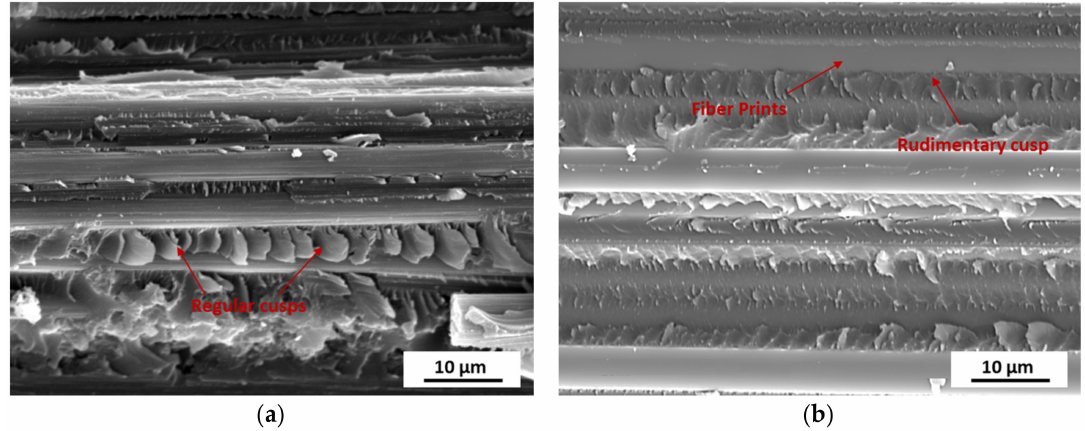
Figure 11. SEM images of fracture surface in short-beam shear tests of laminates post-cured for various time: ( a ) unidirectional laminate after post-curing at 180 ◦ C for 2 h; ( b ) unidirectional laminate after post-curing at 180 ◦ C for 1